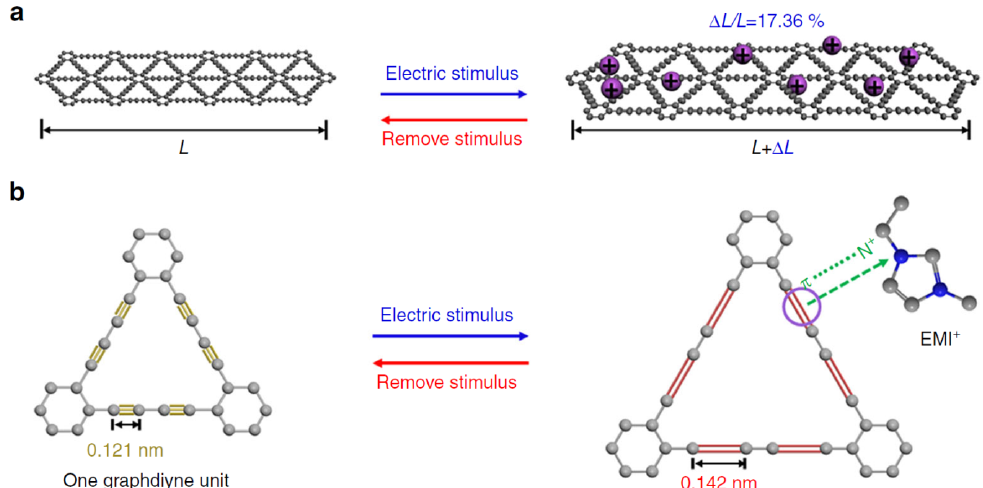
Figure 25. Actuation mechanism of the graphdiyne material: ( a ) schematic of the actuation tension of graphdiyne when interacting with an electrical stimulus; ( b ) mechanism of the transition between the alkene and alkyne complexes in a separate graphdiyne node. Reproduced from [49] with permission from Springer Nature. Copyright 2018.